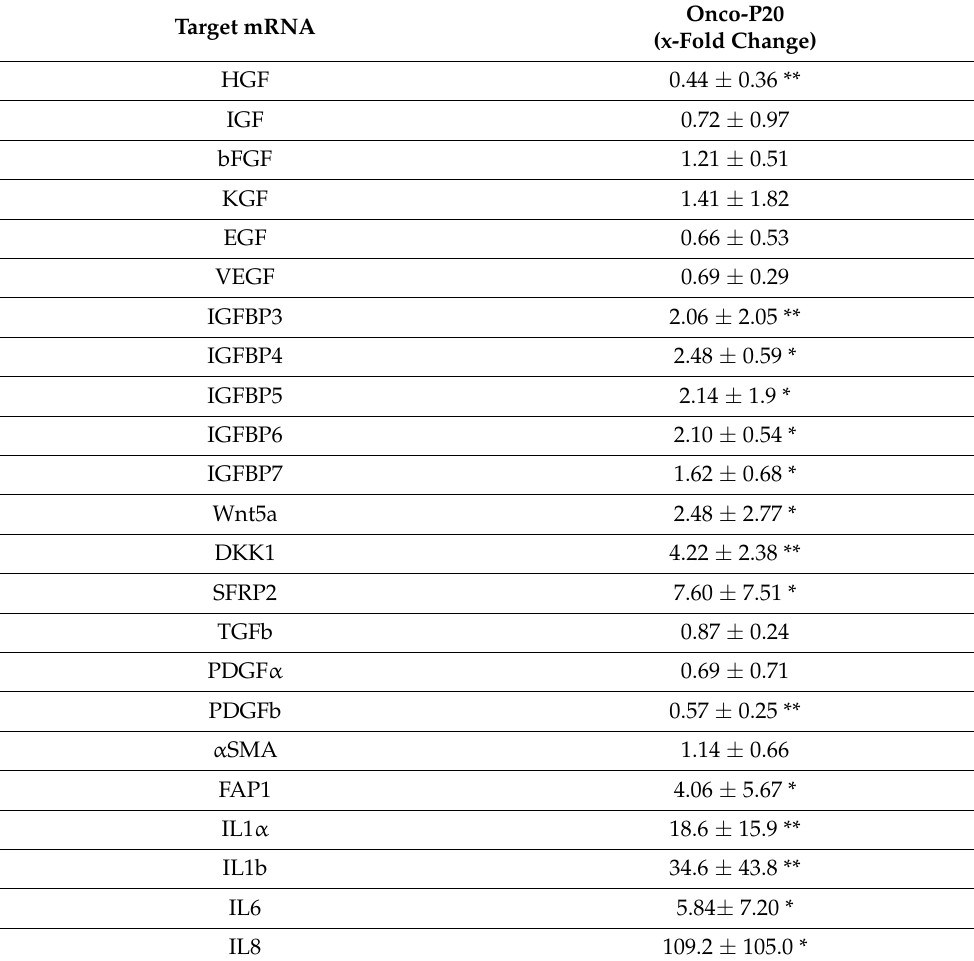
Table 1. Gene expression analysis of growth factors and CAF markers in Onco-P20-treated fibroblasts after 2 weeks of continuous treatment. Data represent x-fold increase or decrease with respect to untreated cells. Results are mean ± SD of seven different experiments performed with fibroblasts isolated from independent donors. * p < 0.05 and ** p <